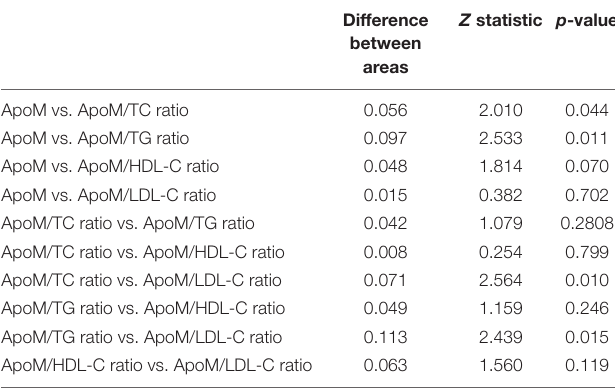
TABLE 3 | Pairwise comparison of the area under the receiver operator characteristic curves by the DeLong’s test.